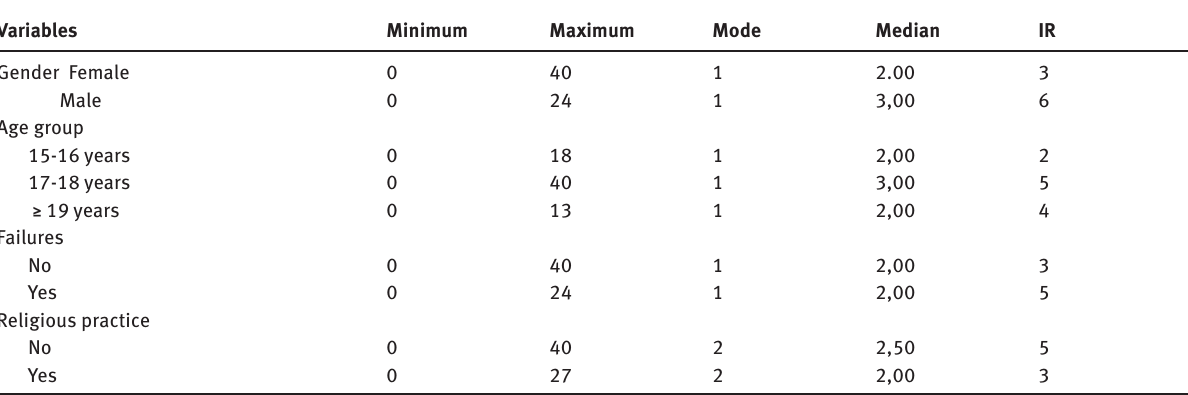
Table 2: Measures of central tendency and dispersion of the scores AUDIT N = 378